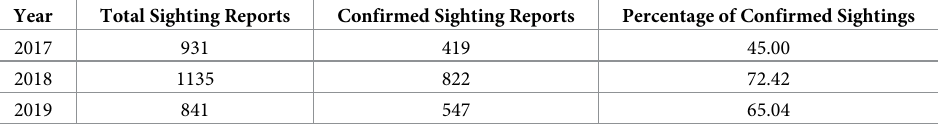
Table 1. Chesapeake DolphinWatch database summary